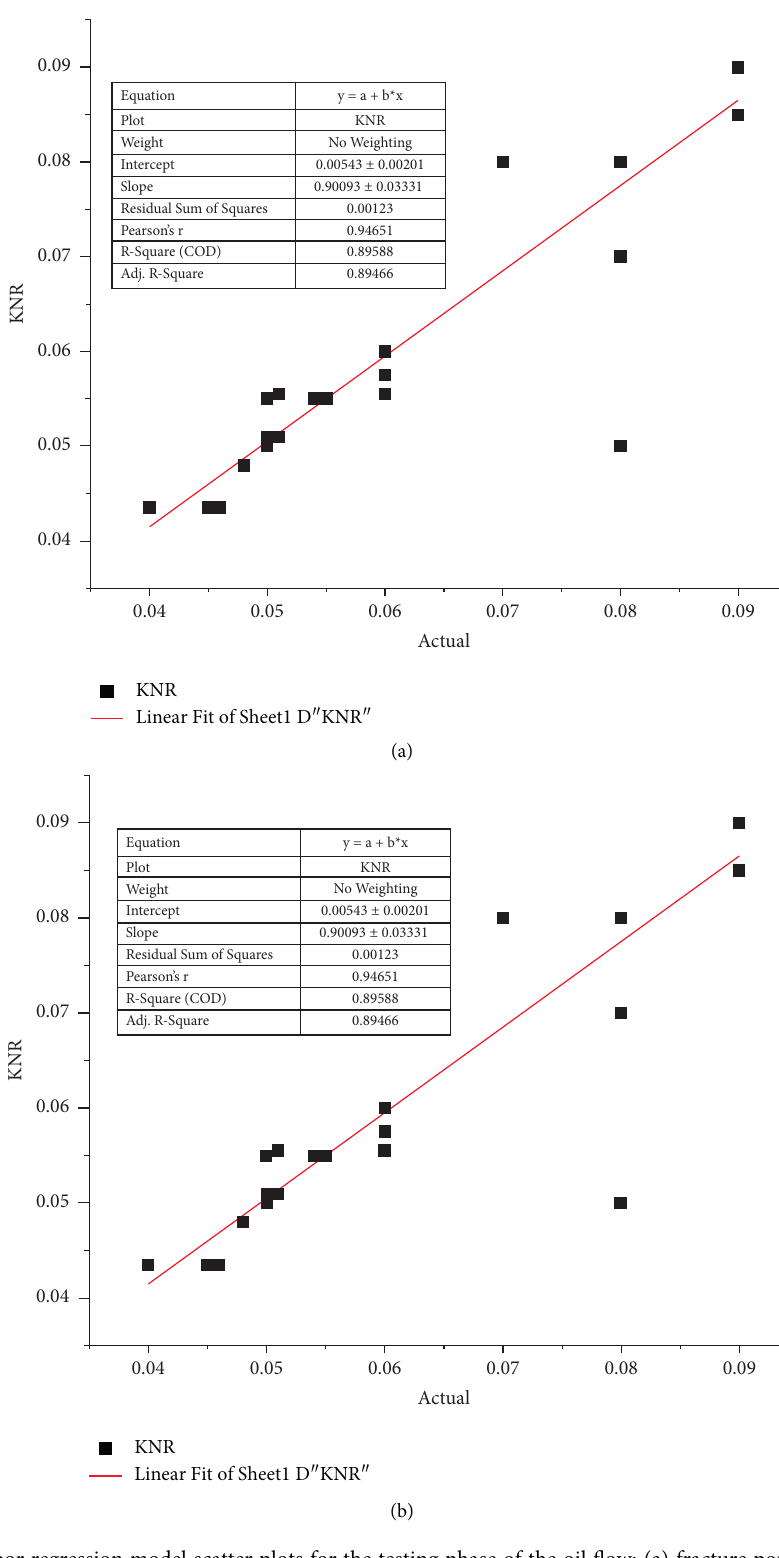
Figure 8: Te K-Neighbor regression model scatter plots for the testing phase of the oil fow: (a) fracture porosity and (b) shape